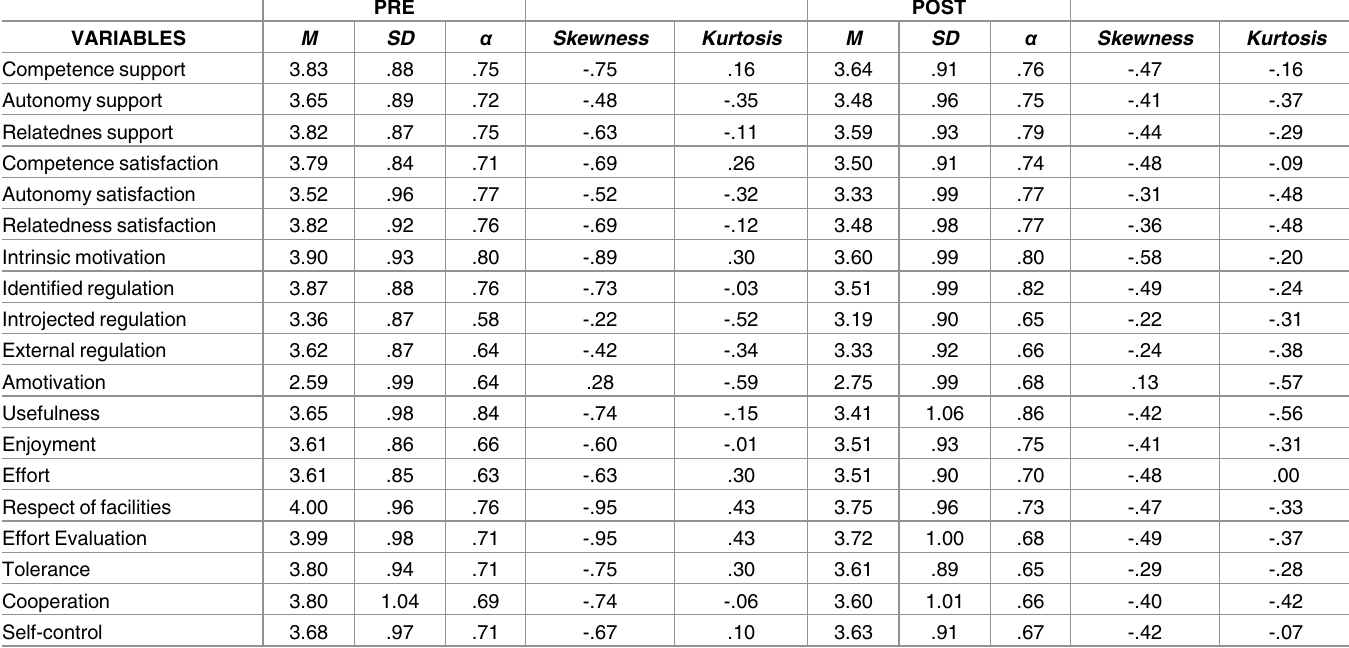
Table 2. Descriptivestatistics and reliability analysis of the study